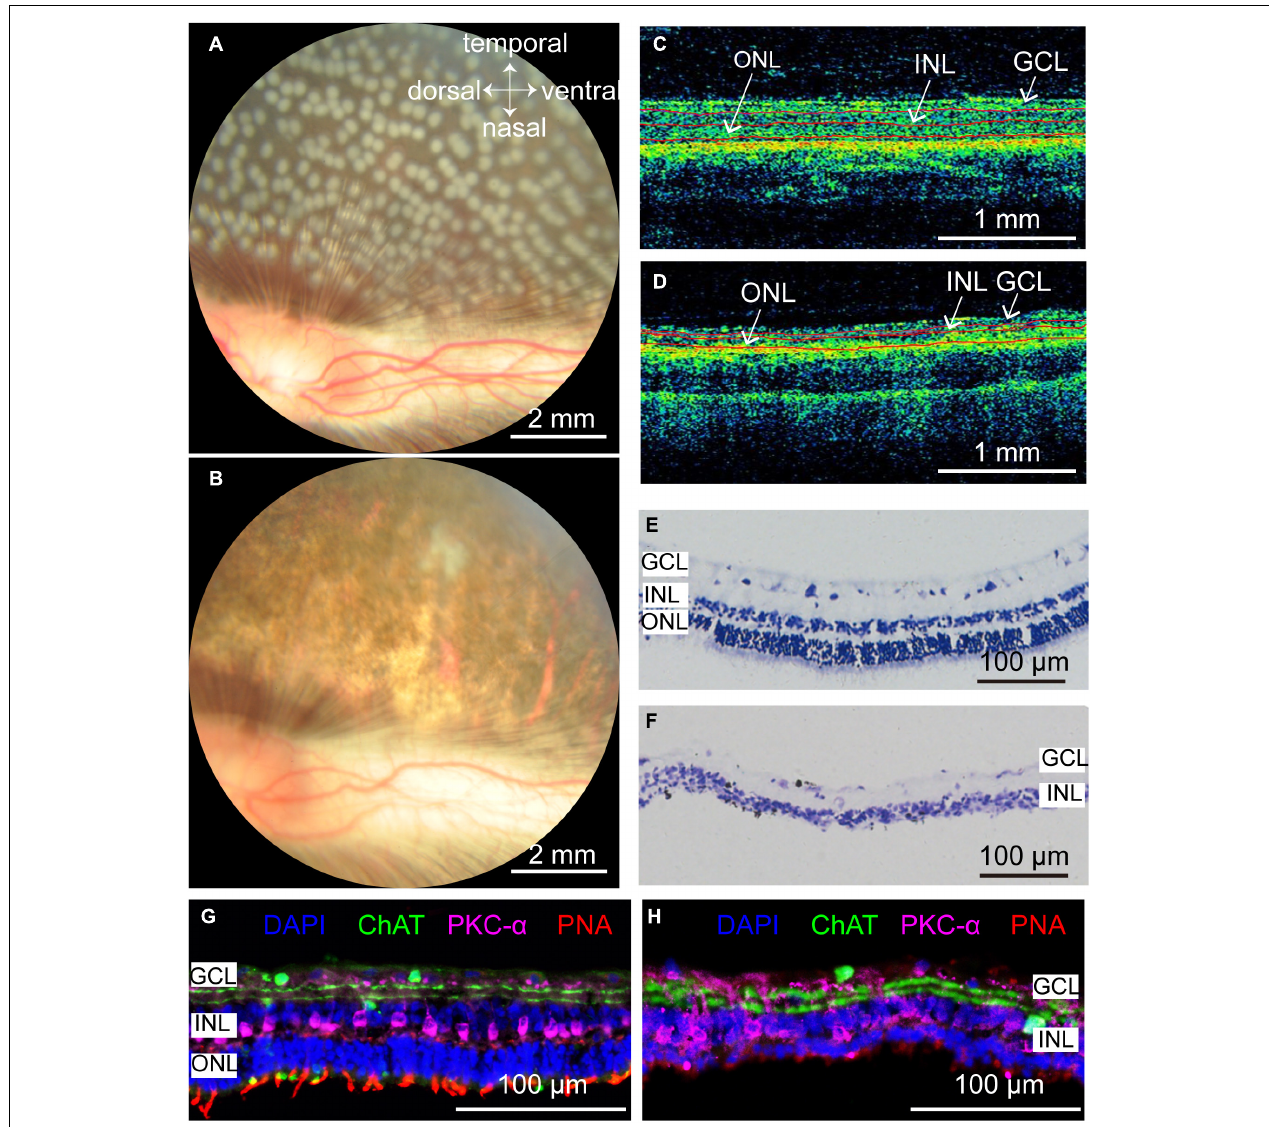
FIGURE 5 | Rabbit retinal photoreceptors across the entire retina were damaged by photocoagulation with 100 mW laser power, 50 ms pulse duration, and 500 µ m laser spot size. (A,B) Fundus photographs of extensive damage of retinal photoreceptors at 1 h and 7 days after photocoagulation. Scale bar = 2 mm. (C) Control OCT image of rabbit retina. Scale bar = 1 mm. (D) Example of OCT image of rabbit retina at 7 days after photocoagulation. Scale bar = 1 mm. Red lines in (C,D) mark retina stratification. (E,F) Histomorphology of control rabbit retina (E) and rabbit retina 7 days after photocoagulation (F) . Scale bar = 100 µ m. (G,H) Immunofluorescence staining of control rabbit retina (G) and rabbit retina 7 days after photocoagulation (H) with cone outer segments marker PNA, bipolar cell marker PKC- α and amacrine cell marker ChAT 7 days after photocoagulation. Scale bar = 100 µ m. GCL, ganglion cell layer; INL, inner nuclear layer; ONL, outer nuclear